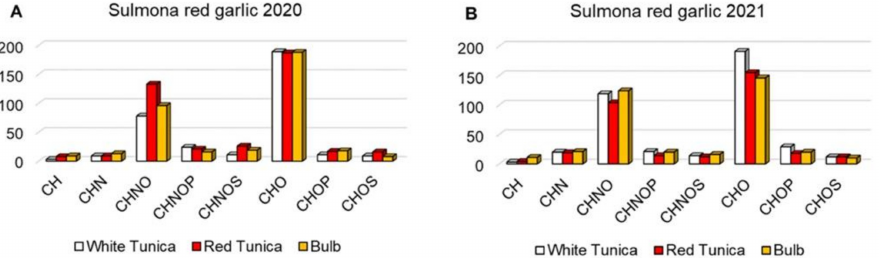
Figure 3. Histograms of relative frequency of CH, CHN, CHNO, CHNOP, CHNOS, CHO, CHOP, and CHOS comparing W, R, B 2020 ( A ) and W, R, B 2021 ( B